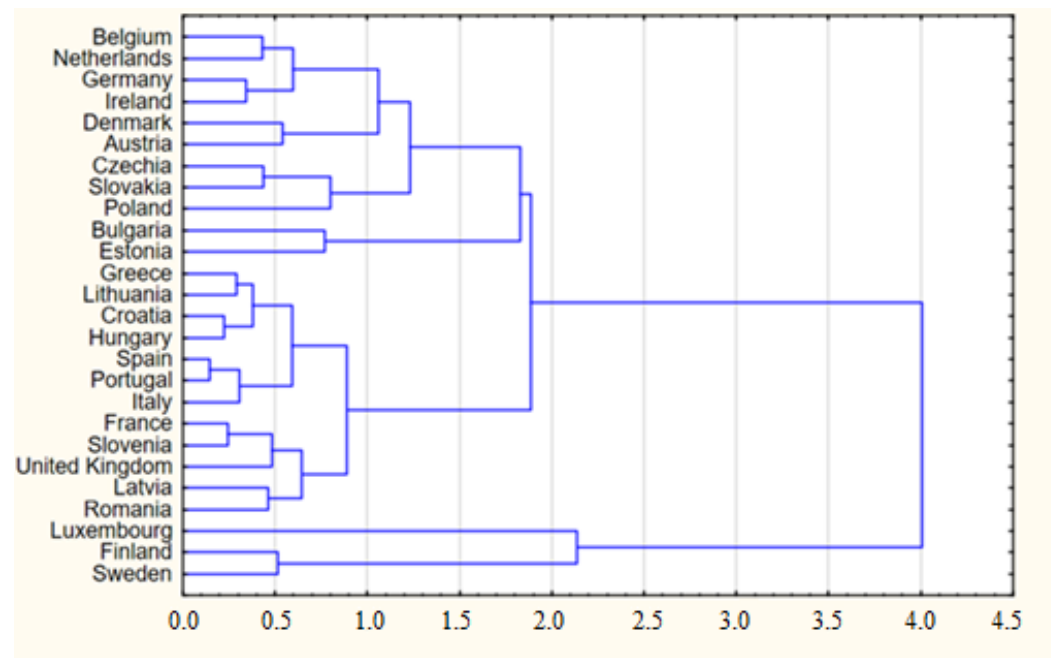
Figure 3. Tree diagram with the Ward method and Euclidean distance in the agglomeration procedure. Source: (own elaboration).